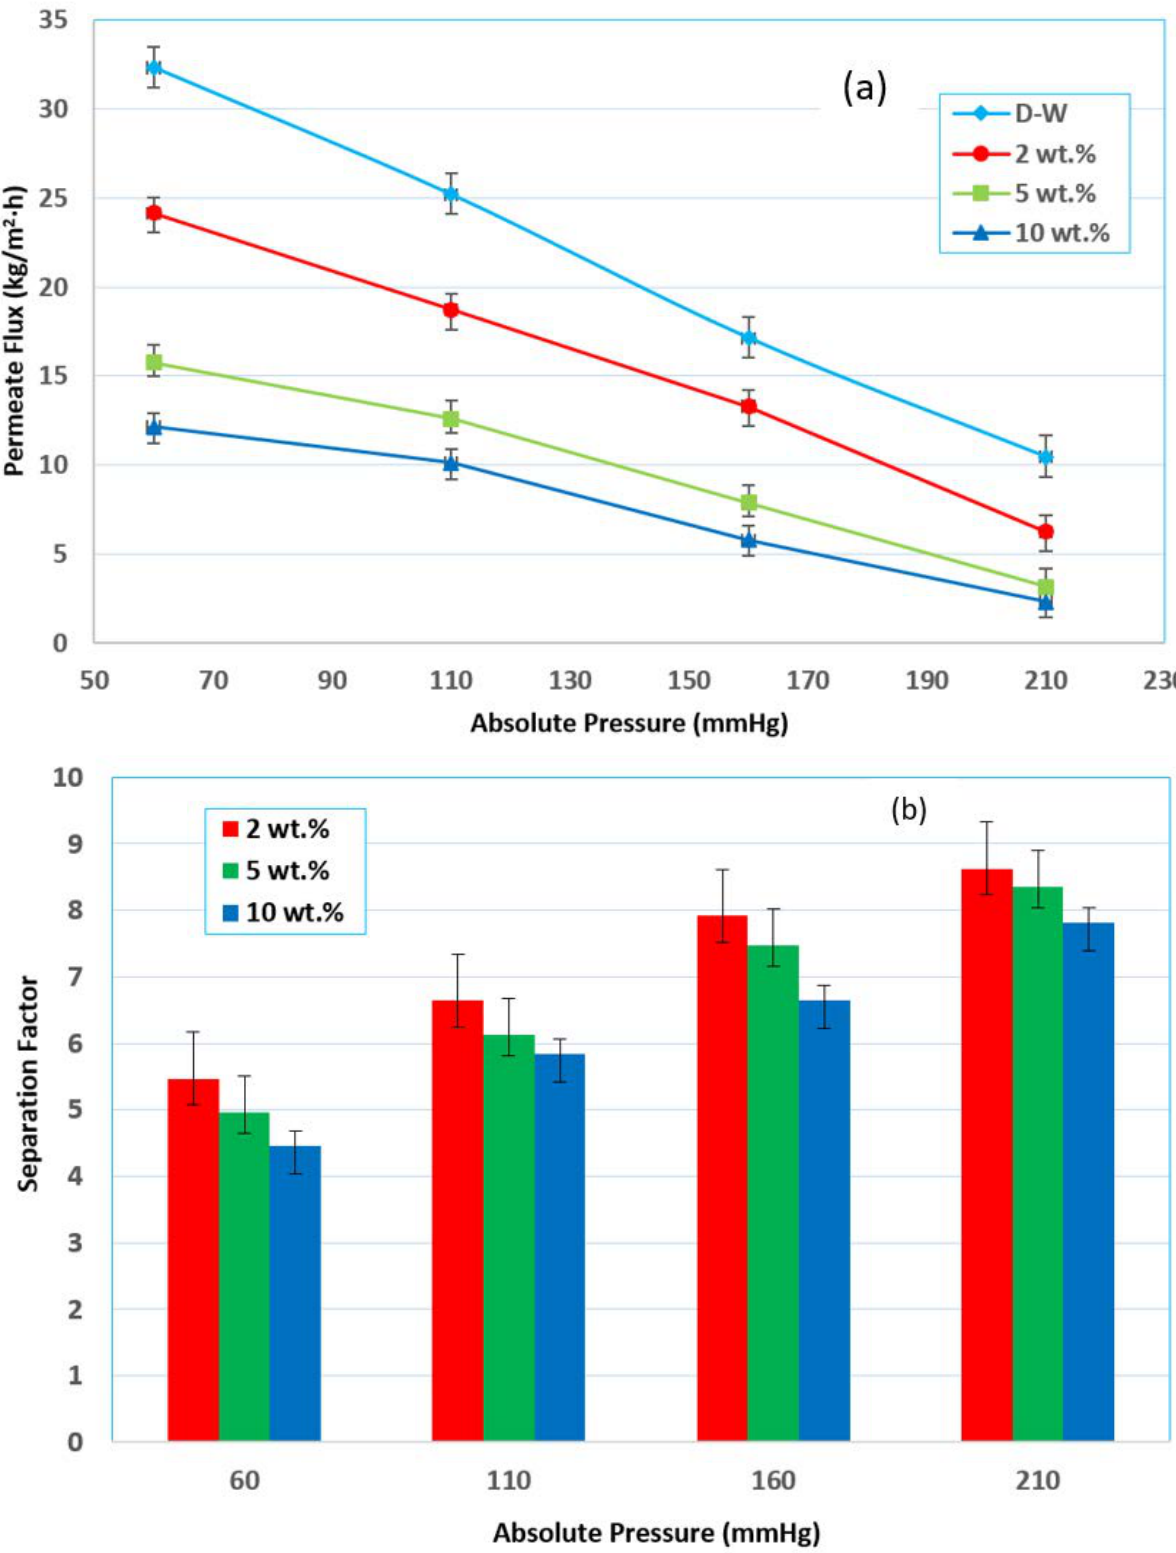
Figure 7. Effect of absolute pressure (in vacuum zone) on ( a ) the permeate flux, and ( b ) the separation factor for a feed temperature at 30 ◦ C, a 0.6 L/min feed flow rate, and different initial